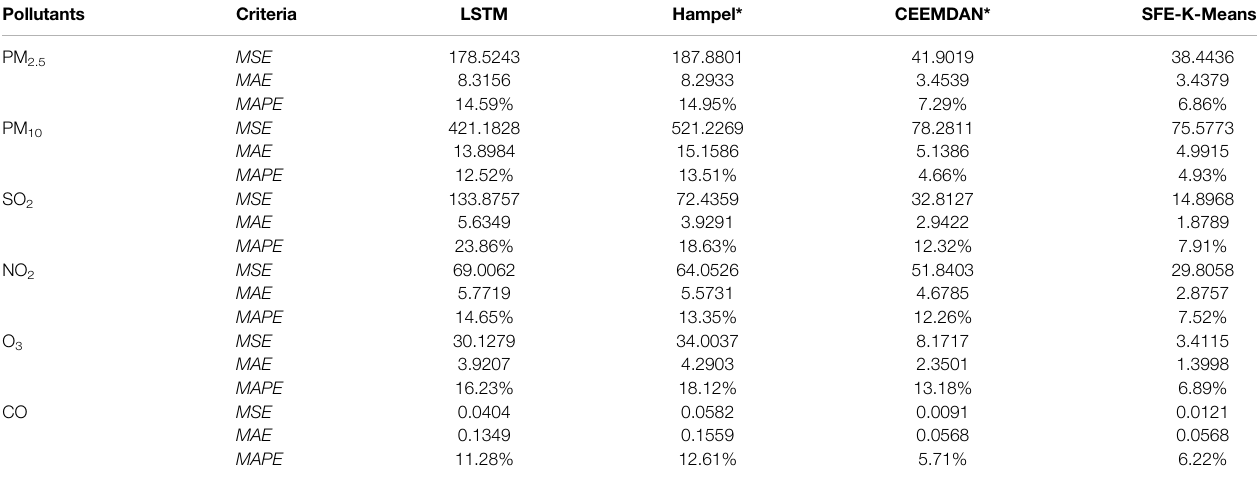
TABLE 4 | Prediction performance of data preprocessing